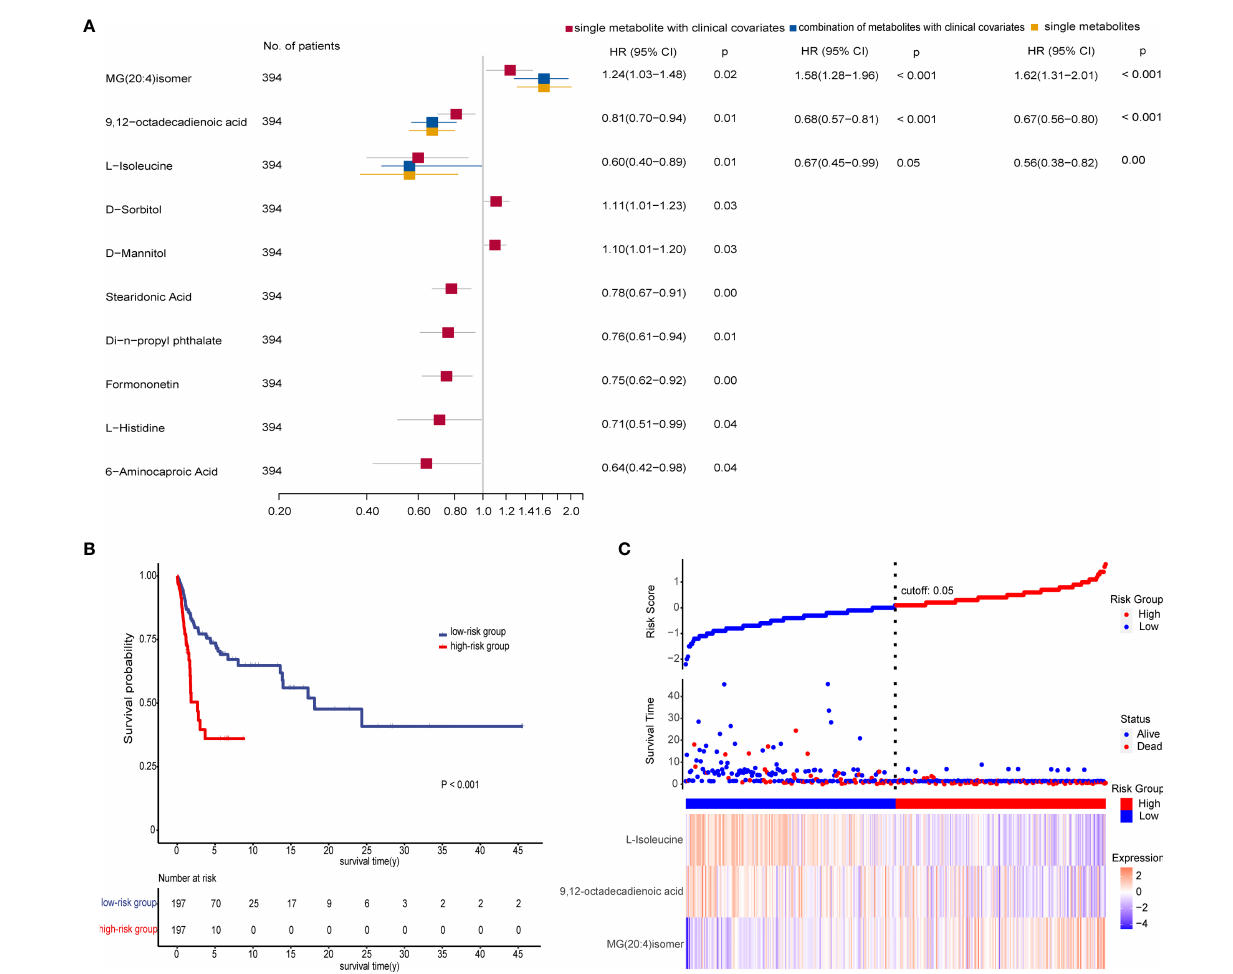
early detection and prognosis revealed that linoleic acid metabolism was the most signi fi cant pathway ( p < 0.05, Figure 6B ) mapped by 9,12-octadecadienoic acid.